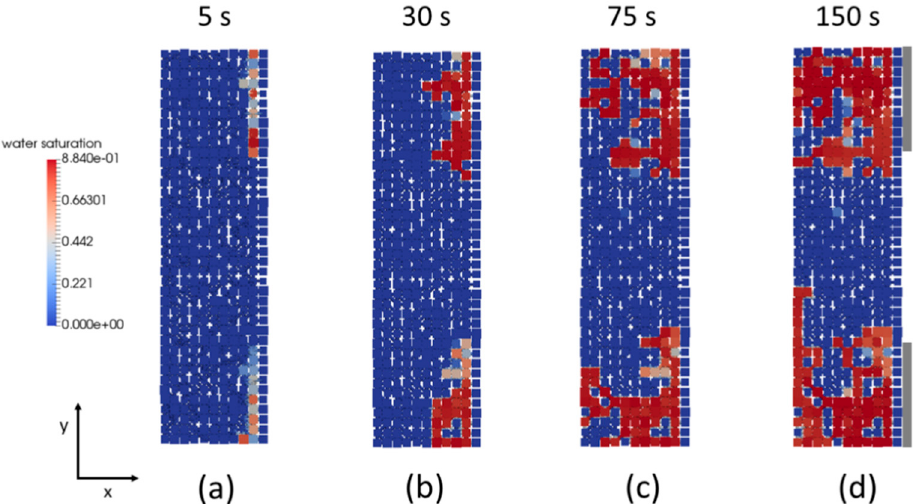
Figure 8. Temporal evolution of water saturation and liquid water clusters in the GDL in case 2. In comparison to the parameters used in case 1, the thermal conductivity of the GDL was set to 0.7 W/m·K.